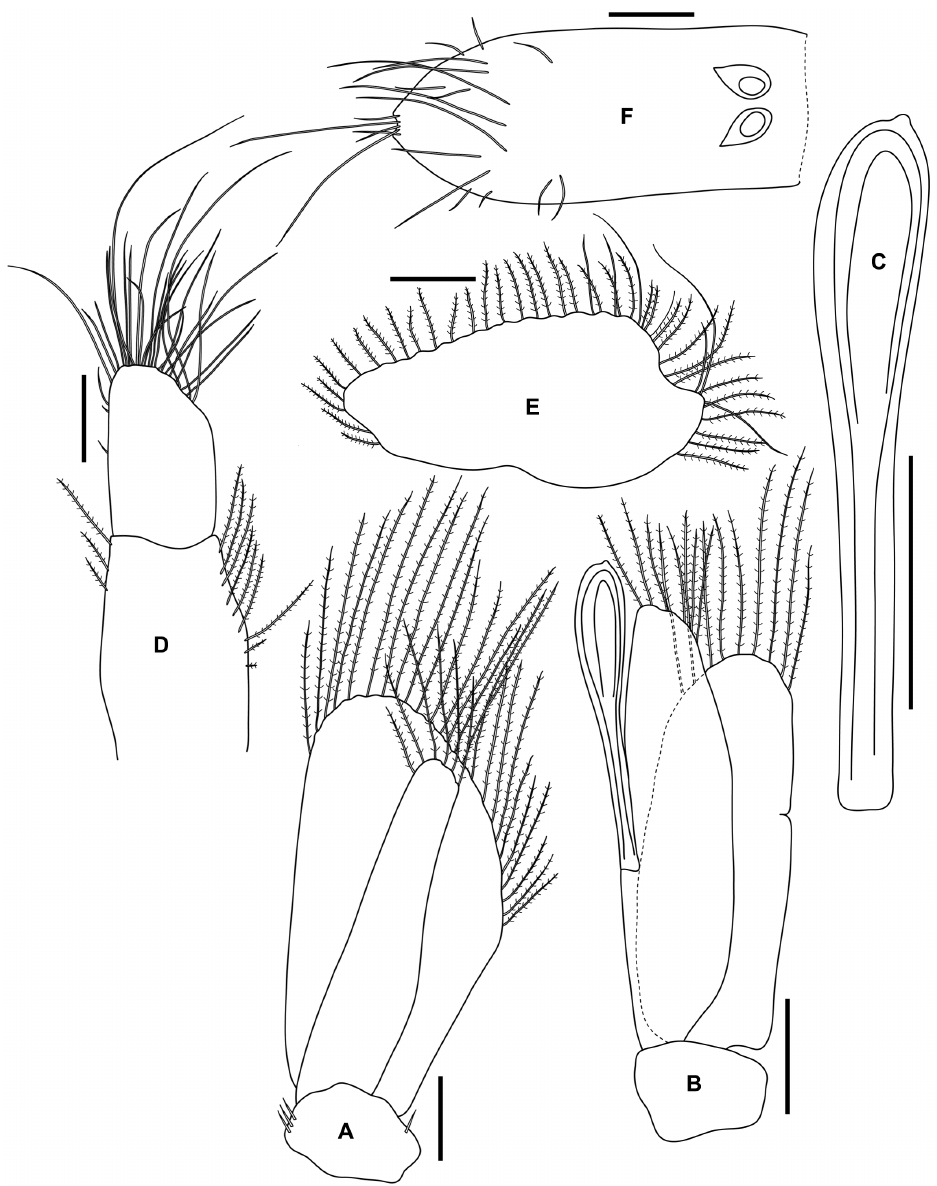
Figure 9. Tinggianthuraalba sp. n., allotype, male, (UKMMZ-1480). All scales represent 0.1 mm. (A) pleopod 1, (B) pleopod 2, (C) appendix masculina, (D) uropodal endopod, (E) uropodal exopod, (F)